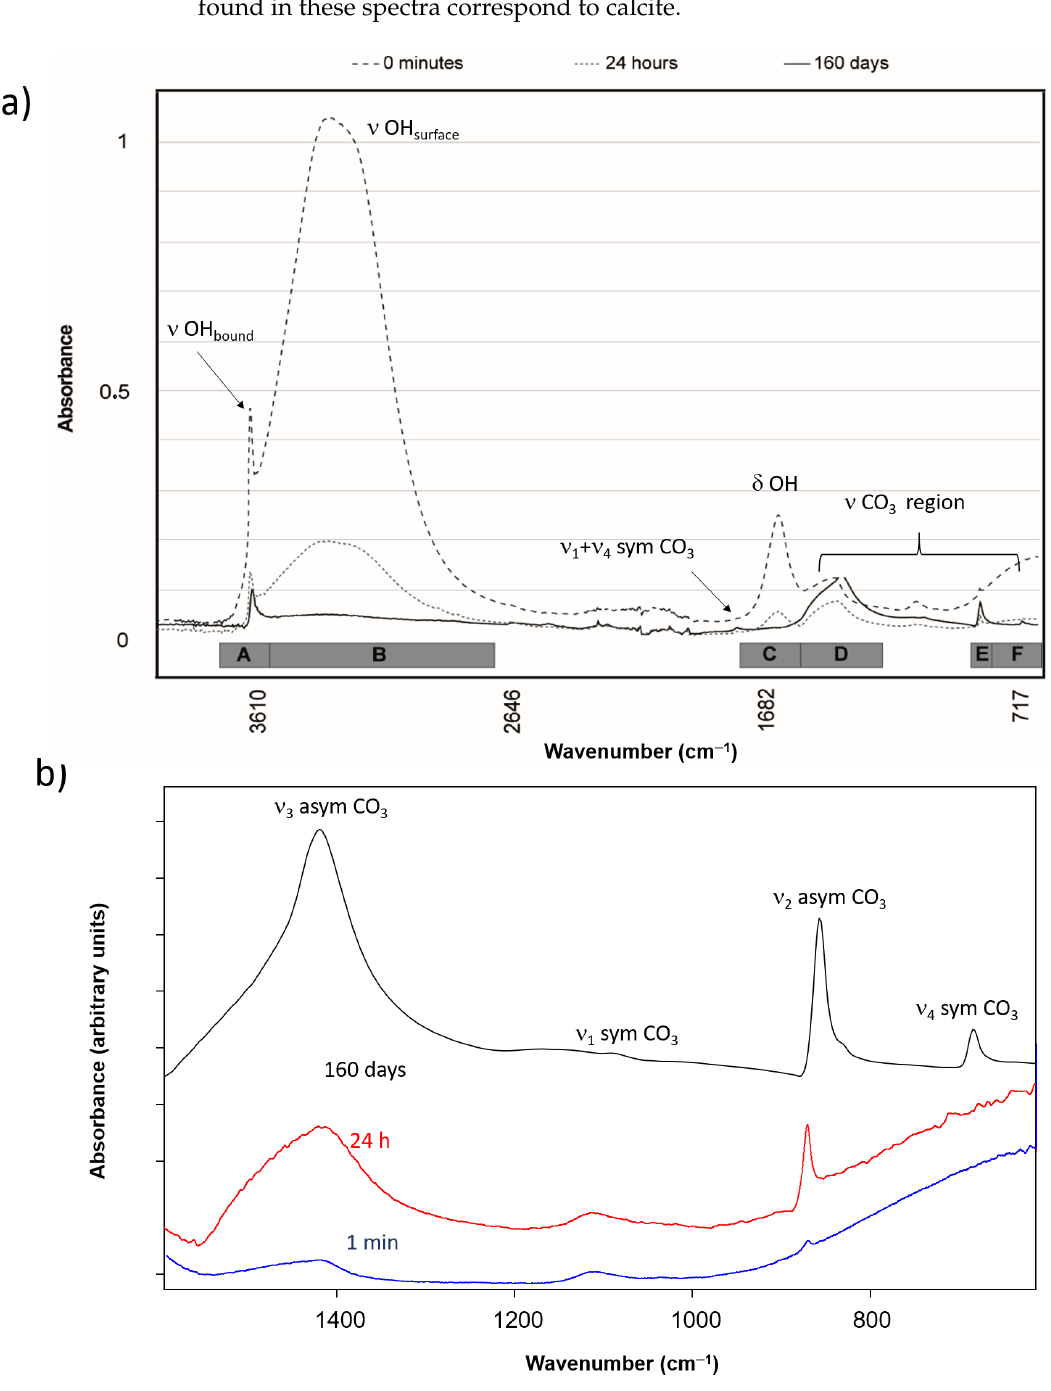
Figure 6. ( a ) IR spectra of samples taken from the surface of test tubes initially, after 24 h and after 160 days; ( b ) Detail of the 1500 – 600 cm −1 region for the IR spectra. The asymmetry observed in the shape of the broad ν 3 stretching carbonate band suggests that it is composed of at least two overlapped bands ascribed to ACC with maxima